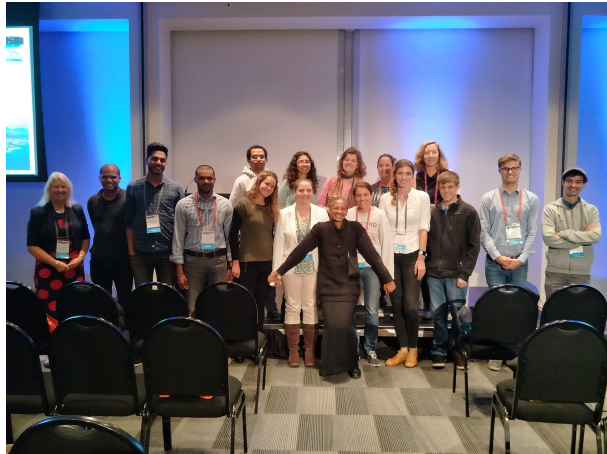
Figure 11. The IIOE-2 ECS meeting in Cape Town (source: IAPSO